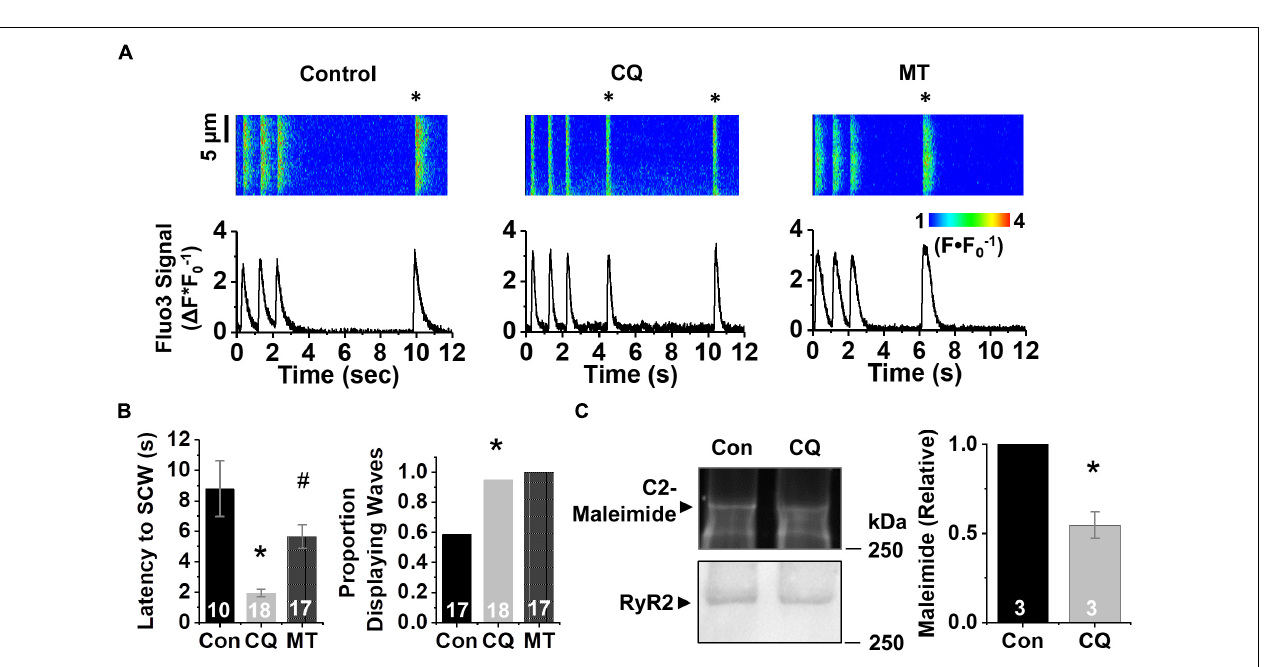
FIGURE 3 | Inhibition of autophagy reduces refractoriness of RyR2-mediated Ca 2 + release under β -adrenergic stimulation. (A) Confocal line scan images and Fluo3 profiles at the end of 1 min 1 Hz pacing train with HL-1 CMs treated with chloroquine or vehicle; all with 100 nM isoproterenol. SCWs are indicated by an asterisk. (B) Mean data for SCW latency and proportion of cells exhibiting SCWs (proportion data ∗ p < 0.05, Fisher’s exact test). (C) Representative C2-maleimide fluorescence of RyRs from HL-1 CMs treated with chloroquine or vehicle. Relative maleimide fluorescence scored between conditions. n = 3 biological preparations from sequential passages. ∗ p < 0.05, all values are mean ± SEM. # p < 0.05 compared to